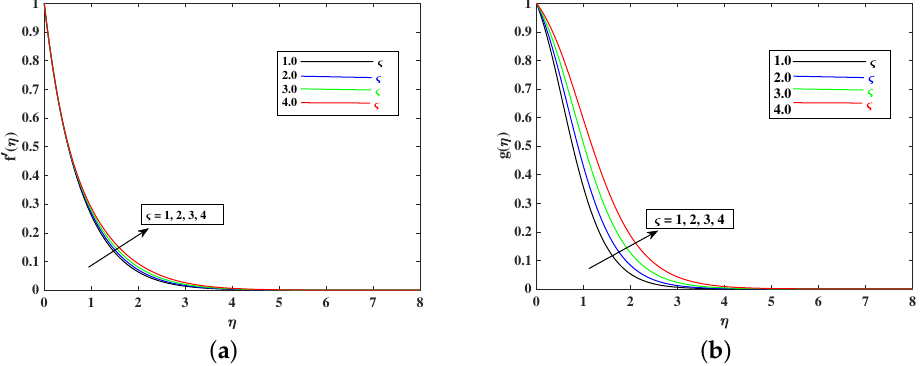
Figure 8. Variation of ς to influence the velocity and temperature profile. ( a ) Variation of ς to influence the velocity. ( b ) Variation of ς to influence the temperature.